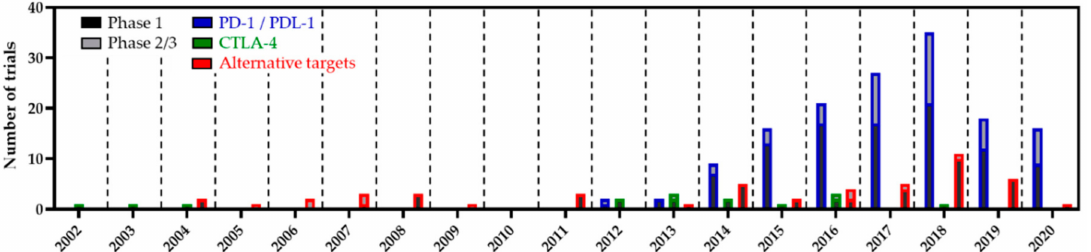
Figure 2. Clinical evolution of immune checkpoint-based therapies in B-cell lymphoma over the last 20 years (according to https://beacon-intelligence.com/checkpoint; data actualised in September